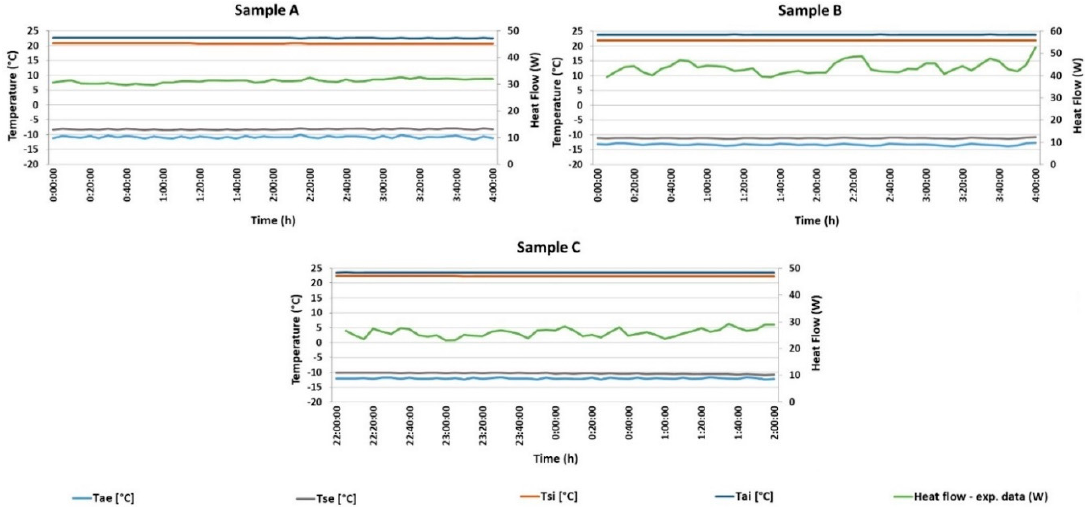
Figure 6. Heat flow and temperature measurements using the steady-state method: ( A ) short-cut rapeseed (test A2 in Table 4); ( B ) short-cut woodchips (test B2 in Table 5); ( C ) mineral wool (test C1 in Table 6); T ae = air temperature in the cold chamber, T ai = air temperature in the hot chamber, T se = surface temperature of sample in the cold chamber, and T si = surface temperature of sample in the hot chamber.